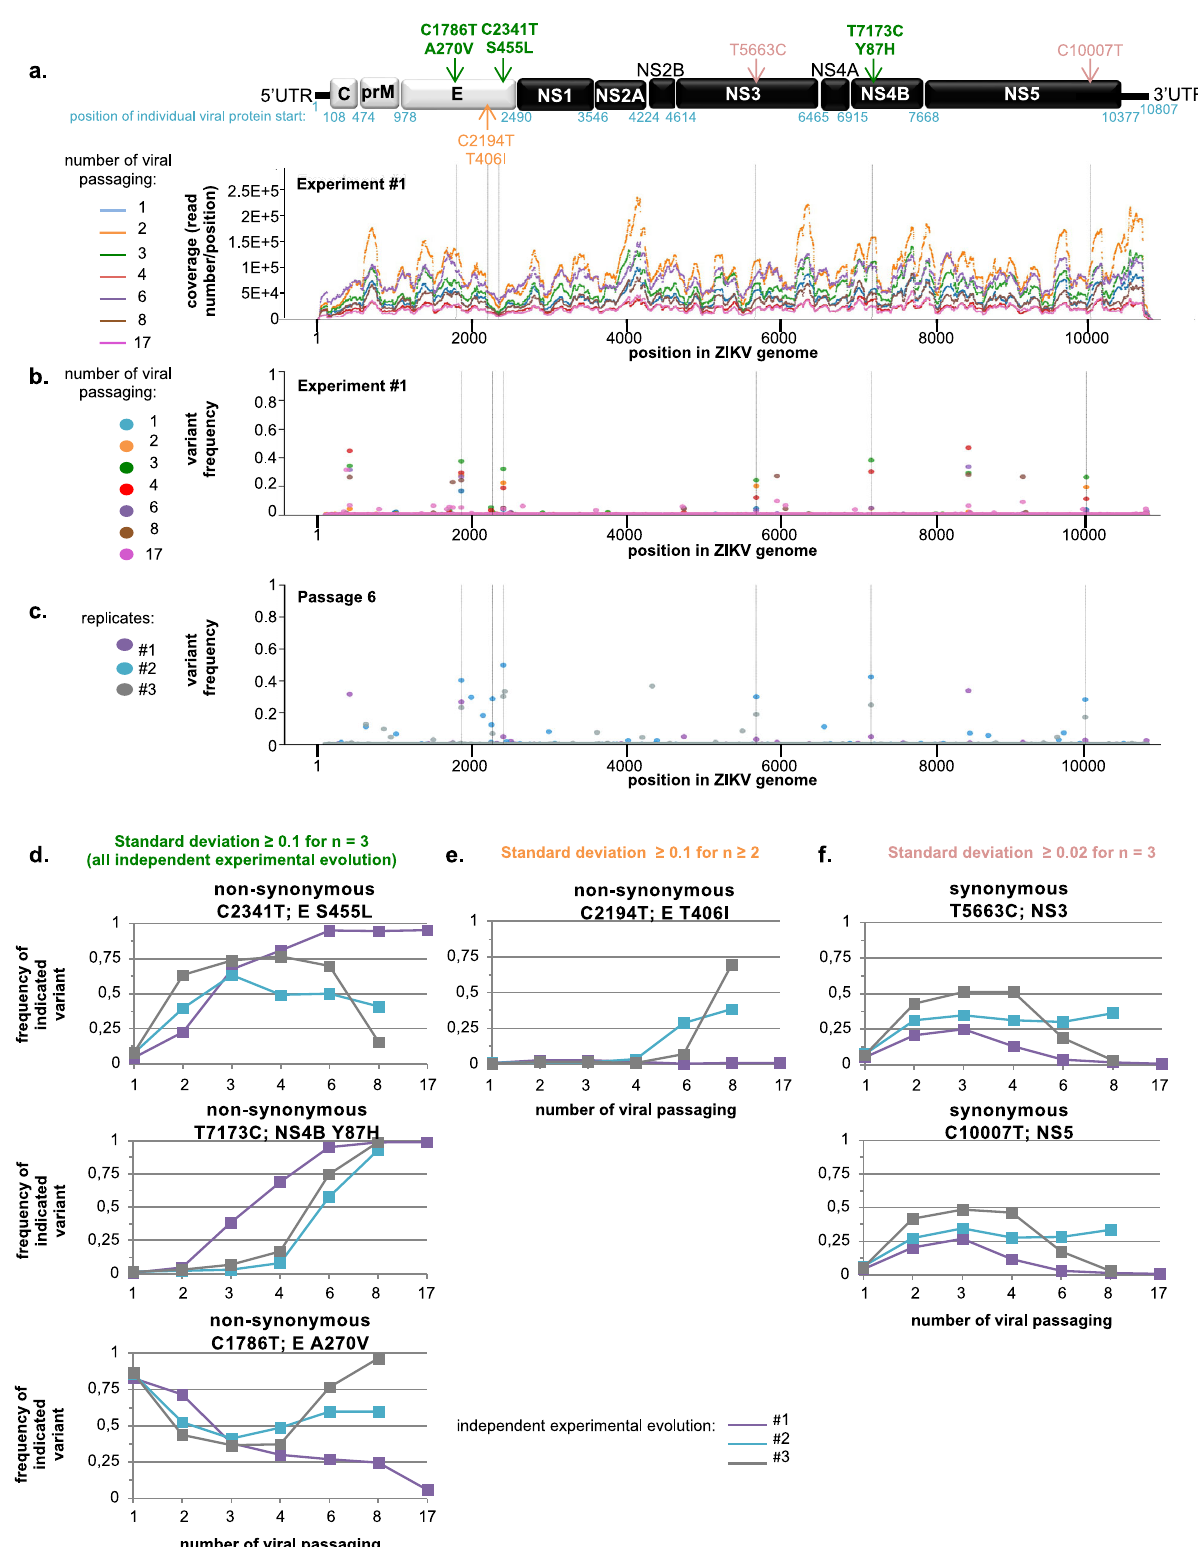
populations adapted in the course of experimental evolution described earlier (Fig. 2a, b). We demonstrated that, similar to the adapted viral populations obtained in the experimental evolution, the E S455L mutant resists inhibition by TLR3-induced antiviral response (Fig. 4d, right curves), as opposed to the reference clone (Fig. 4d, left